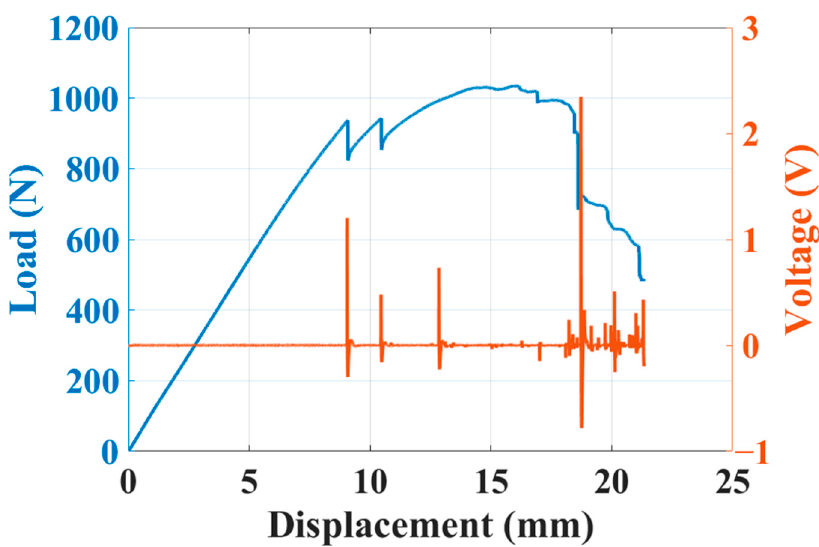
Figure 9. Load–displacement curve and piezoelectric response.